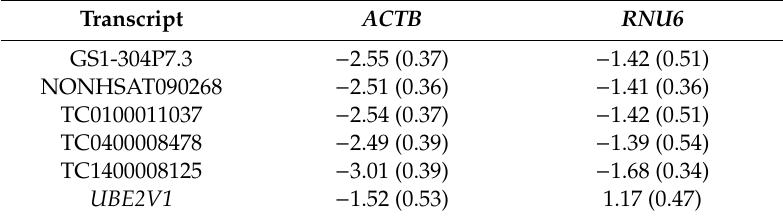
Table 4. Expression analysis performed on PBMCs. For each transcript, median fold change and p -value (between brackets) are shown for each endogenous control ( ACTB and RNU6 ). ACTB : actin beta.